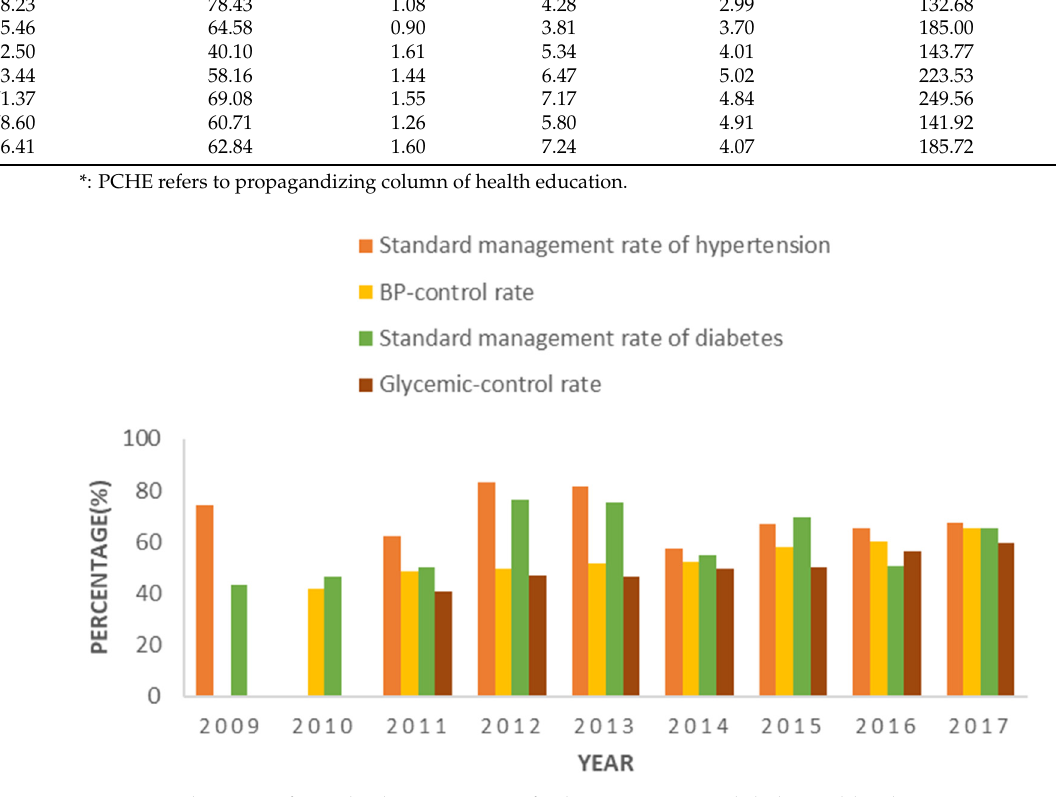
Figure 2. The rates of standard management for hypertension and diabetes, blood pressure control rates, and glycemic control rates from 2009 and 2017 in Inner Mongolia,